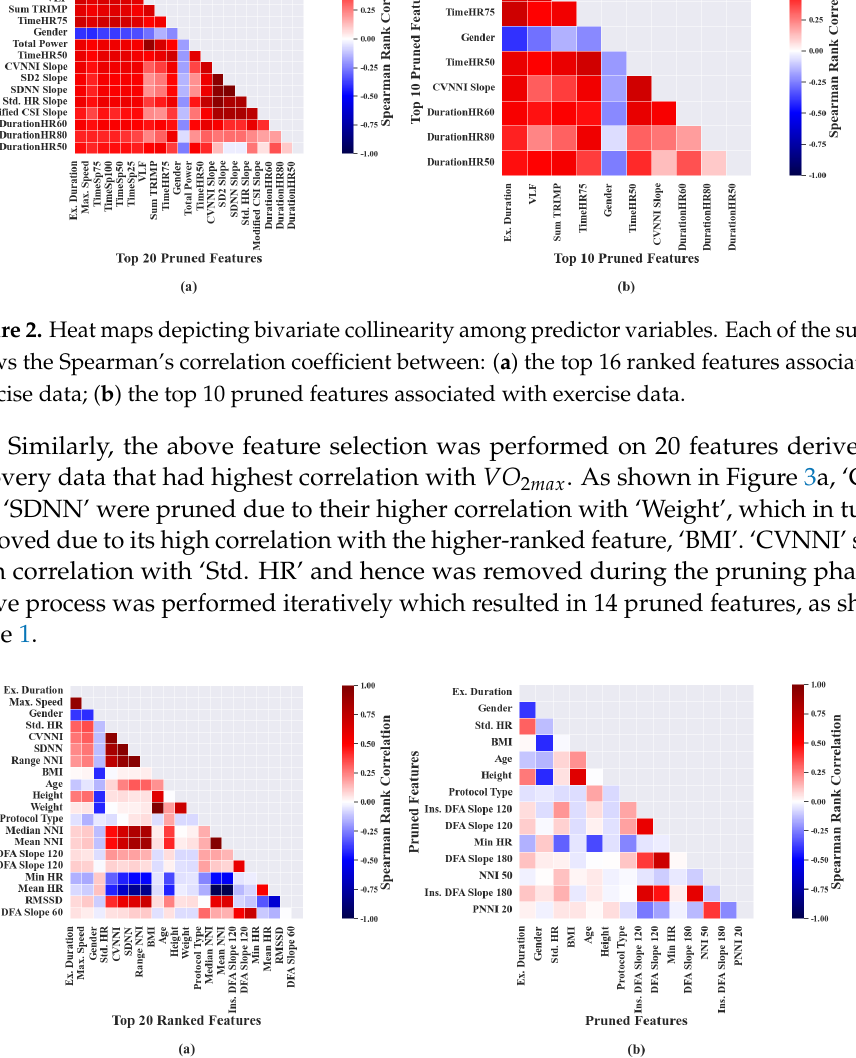
Figure 3. Heat maps depicting bivariate collinearity among predictor variables. Each of the subfigures shows the Spearman’s correlation coefficient between: ( a ) the top 20 ranked features associated with recovery data; ( b ) the pruned features associated with recovery